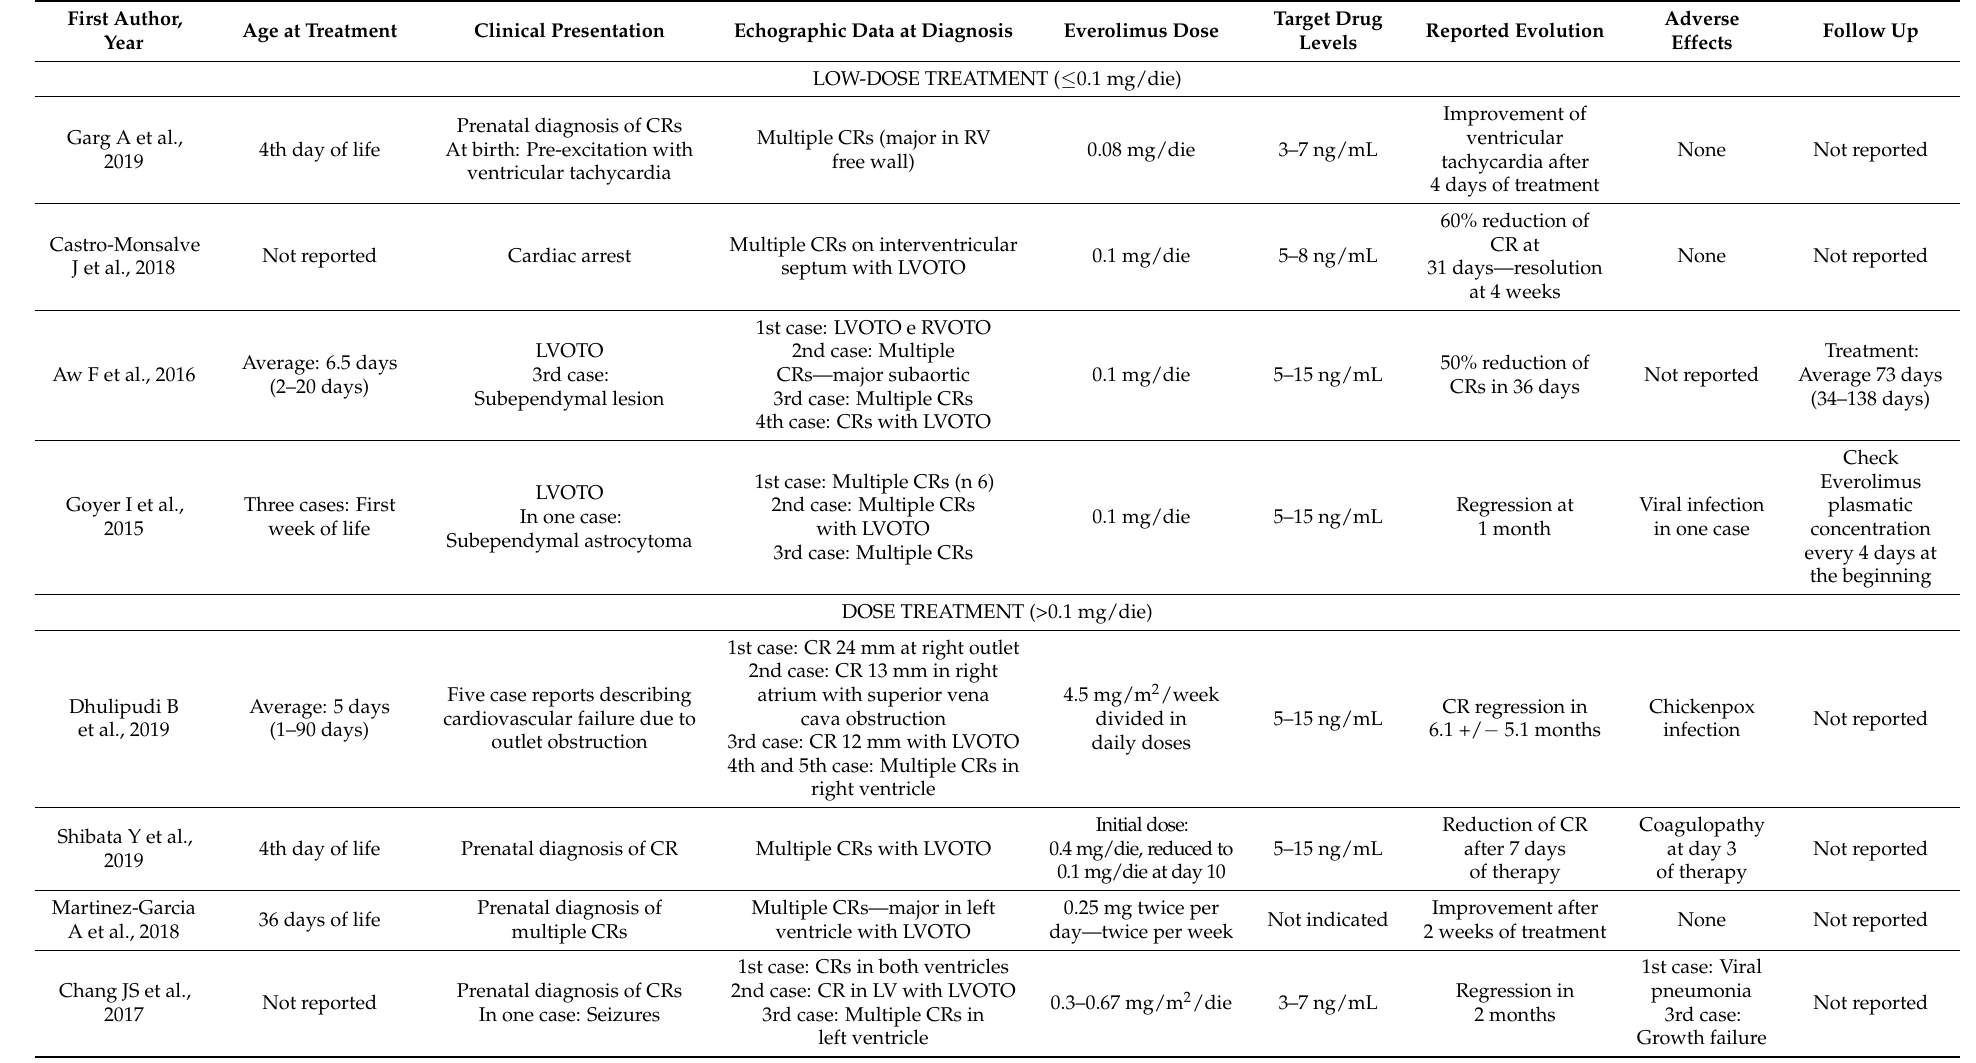
Table 1. Characterization of patients with cardiac rhabdomyomas treated with low doses of Everolimus in the neonatal